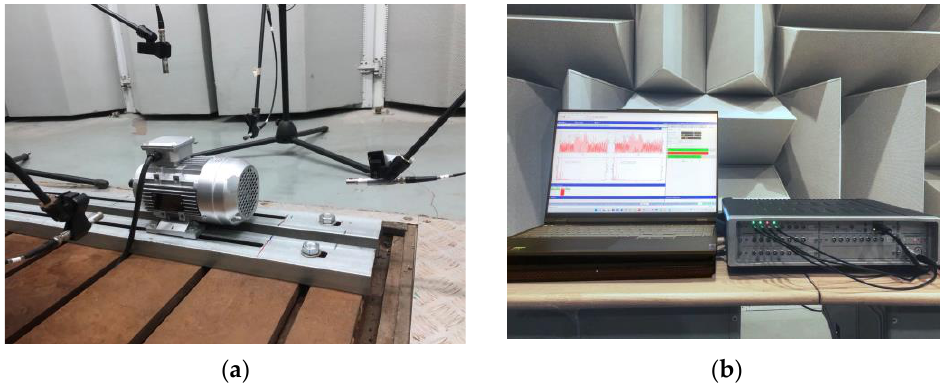
( d ) Figure 7. Original signal and decomposition results of three methods: ( a ) original signal, ( b ) ASSME, ( c ) CSSVMD, ( d ) CSSEWT . Simulation results show that the classical scale space does not perform well in motor noise source separation and cannot correctly distinguish noise signals with complex har- monic and shock components. The classical scale space combined with VMD and EWT algorithms exhibits extensive over-decomposition phenomena and cannot guarantee the validity of the signal. However, signal validity is a prerequisite for the accurate separation and identification of noise sources. The ASSME method avoids the absence of harmonic